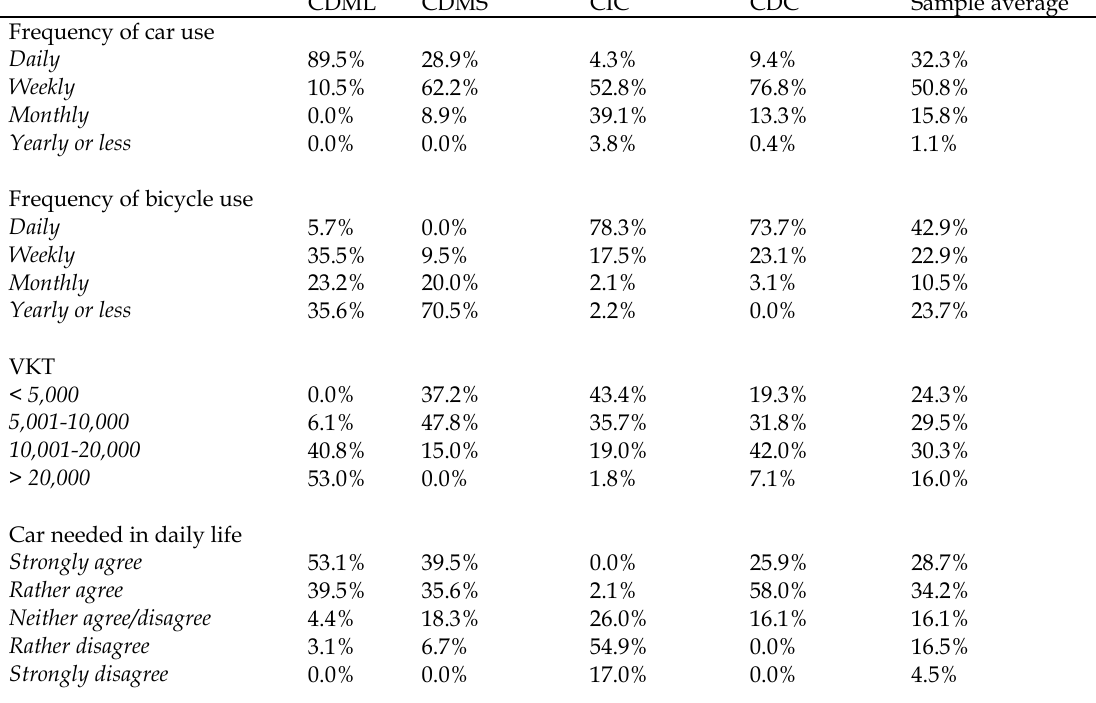
Table 3: Share of respondents per cluster (%), for each constituent variable. CDML CDMS CIC CDC Sample